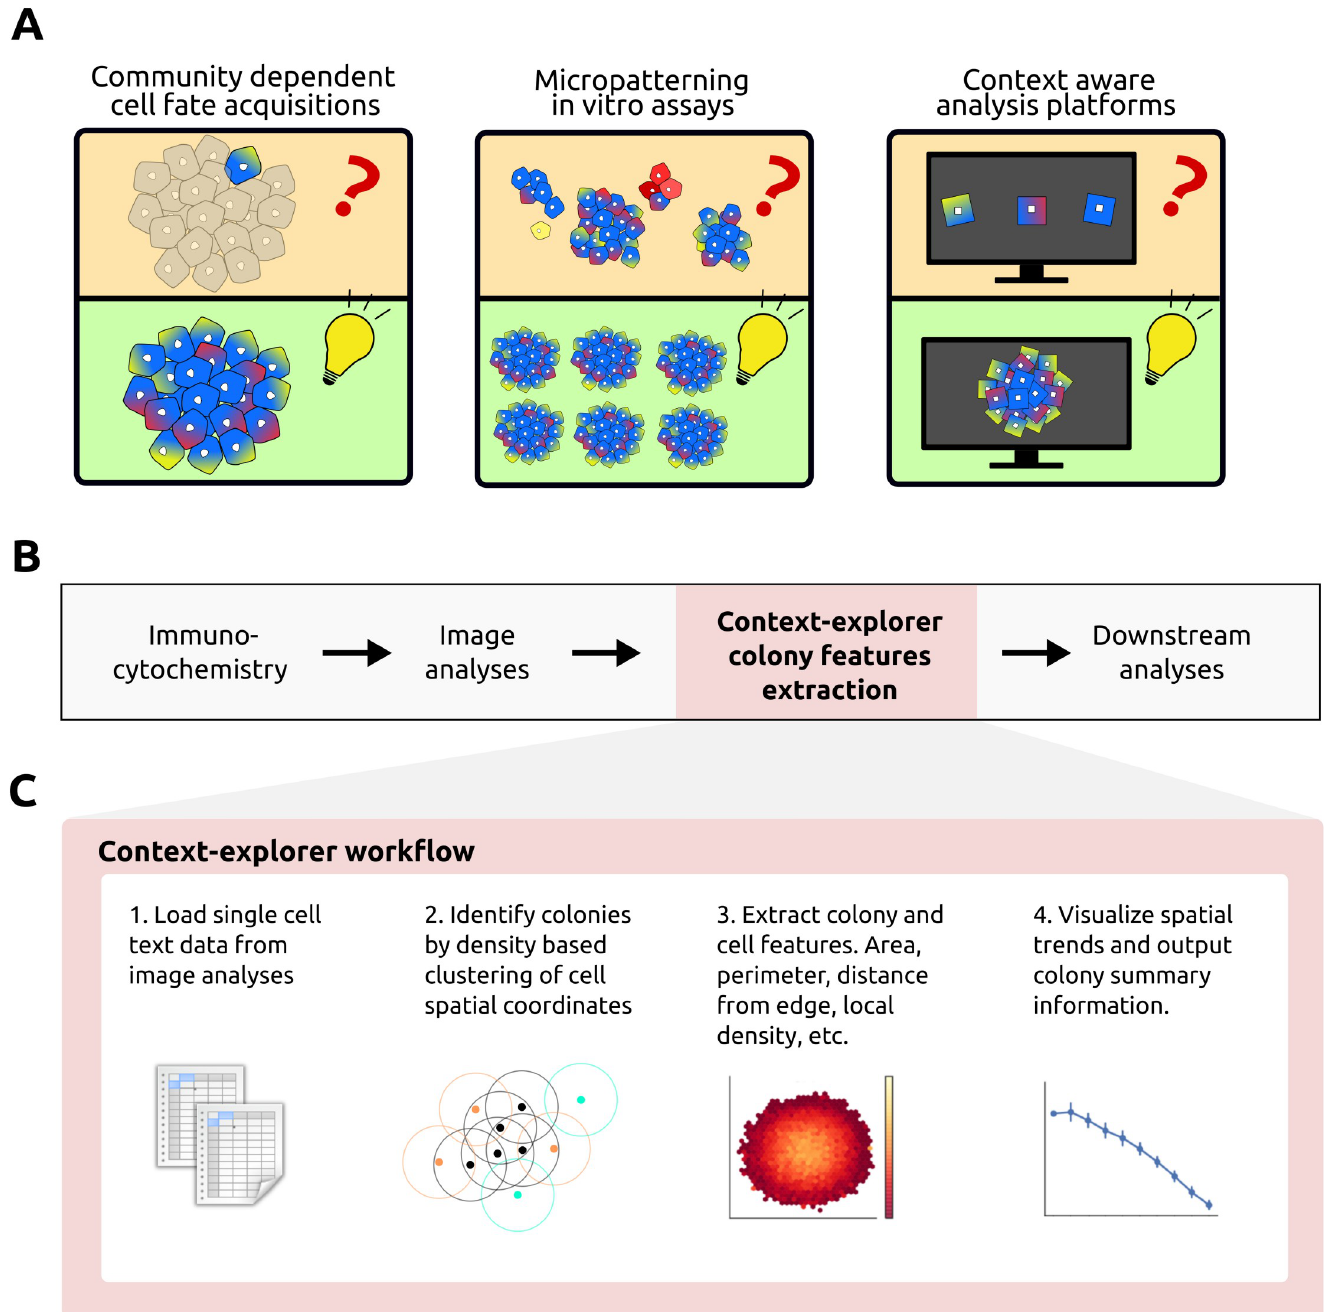
Fig 1. Background schematic and CE workflow overview. A) Studying cells in isolation disregards the effects of community interactions, which are known to direct cell fate decisions ( left ). Powerful micropatterning in vitro assays increase control over the cellular microenvironment and facilitate the study of context dependent cell fate acquisitions ( middle ). Our analysis software enhances these assays by allowing researchers to analyze cell behavior within its population context instead of as independent isolated events ( right ). B) CE fits into existing image analysis pipelines after initial measurements have been extracted from the images. C) Overview of the CE workflow, each step is described in detail in the methods